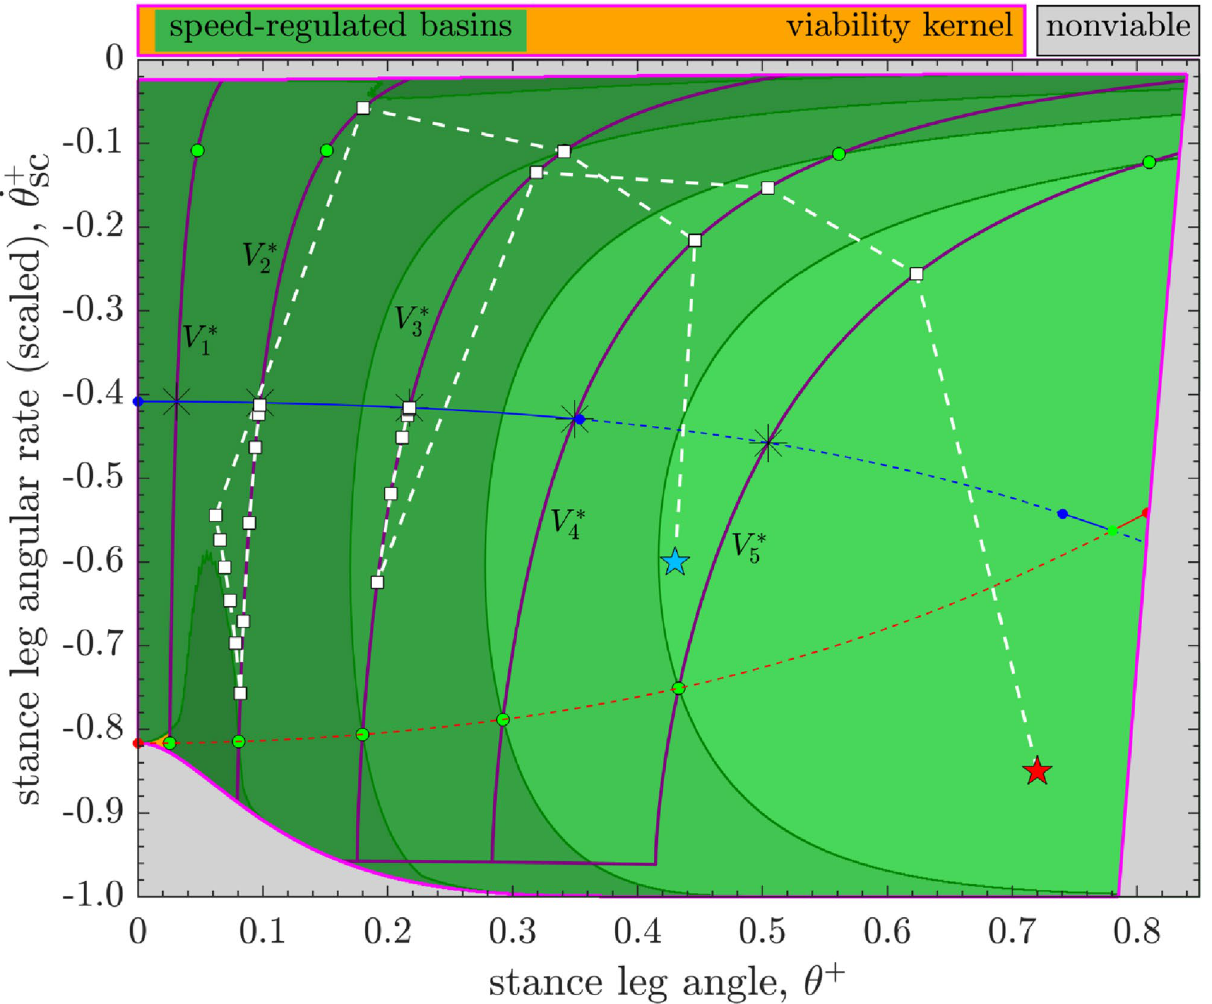
Figure 7. Five of the speed-regulated walker’s basins from Fig. 5 of its long-period steady-state gait ( ) corresponding to the target step speeds, { V ∗ 1 ≈ 0.016, V ∗ 2 ≈ 0.051, V ∗ 3 ≈ 0.113, V ∗ 4 ≈ 0.178, V ∗ 5 ≈ 0.251 } . These five basins together cover > 99.99% of the area of the viability kernel. Also, any two adjacent basins have some overlap with each other. We consider two examples of a scenario where the walker experiences a large disturbance while walking at some desired speed V ∗ f , such that its “disturbed” state ( star pentagons ) lies within the speed-regulated basin B ( V ∗ i ) corresponding to some speed V ∗ i . A sequence of walking steps ( broken lines joining squares ) then illustrates the walker’s post-disturbance recovery back to the steady-state gait ( ) corresponding to speed V ∗ f via task switching control of speed regulators: in example 1 ( star pentagon, red ), V ∗ f = V ∗ 3 , and V ∗ i = V ∗ 5 ; in example 2 ( star pentagon, blue ), V ∗ f = V ∗ 2 , and V ∗ i = V ∗ 4 . In both